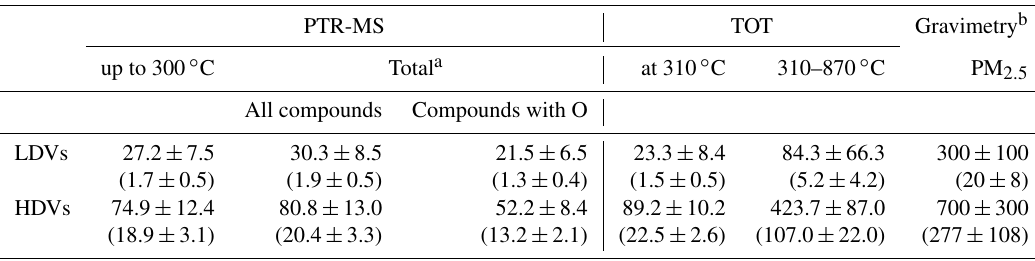
Table 3. OA (TD-PTR-MS), OC (TOT) and PM 2 . 5 average emission factors (EFs, mgkg − 1 of burned fuel), and standard deviations of the filters for LDVs and HDVs (values in brackets correspond to the EF in mgkm − 1 ) .